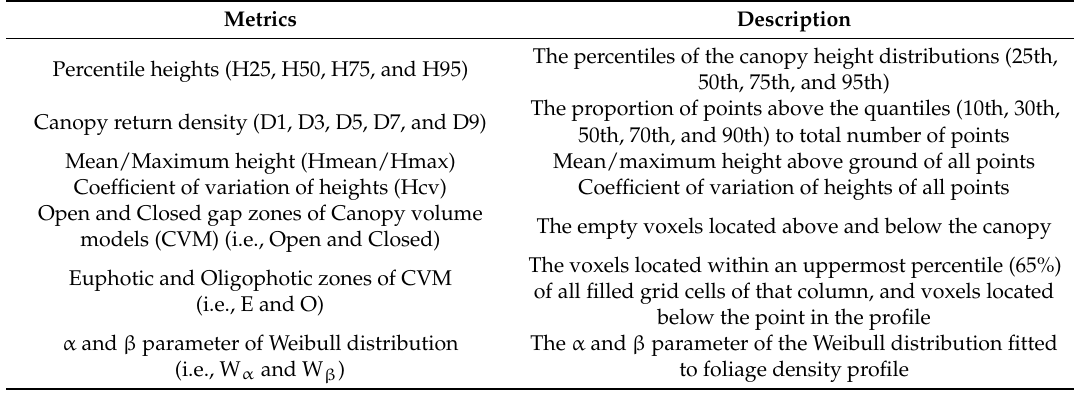
Table 3. The summary of the structural metrics extracted from the digital aerial photogrammetry point cloud (the code and description of each metric are